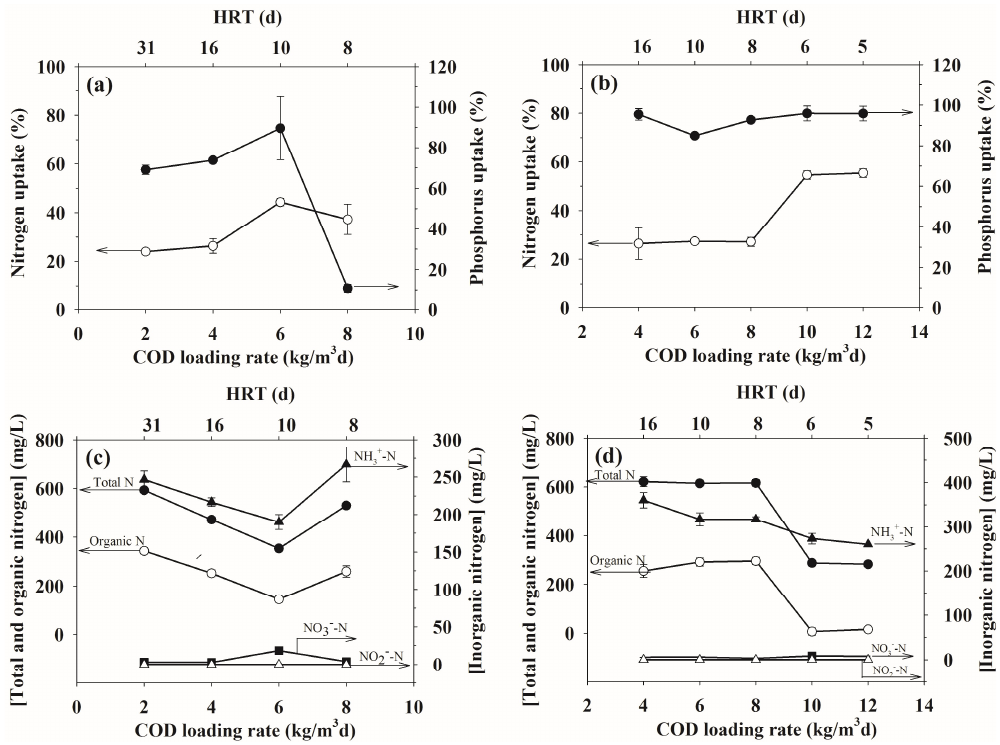
Figure 5. The ( a , b ) macronutrient (N and P) uptake and ( c , d ) total-N, org-N and inorganic-N levels in the ASBR operated at different COD loading rates under a ( a , b ) mesophilic (37 °C) and ( c , d ) thermophilic (55 °C) temperature. Data are shown as the mean ± 1SD, derived from 5 independent repeats.